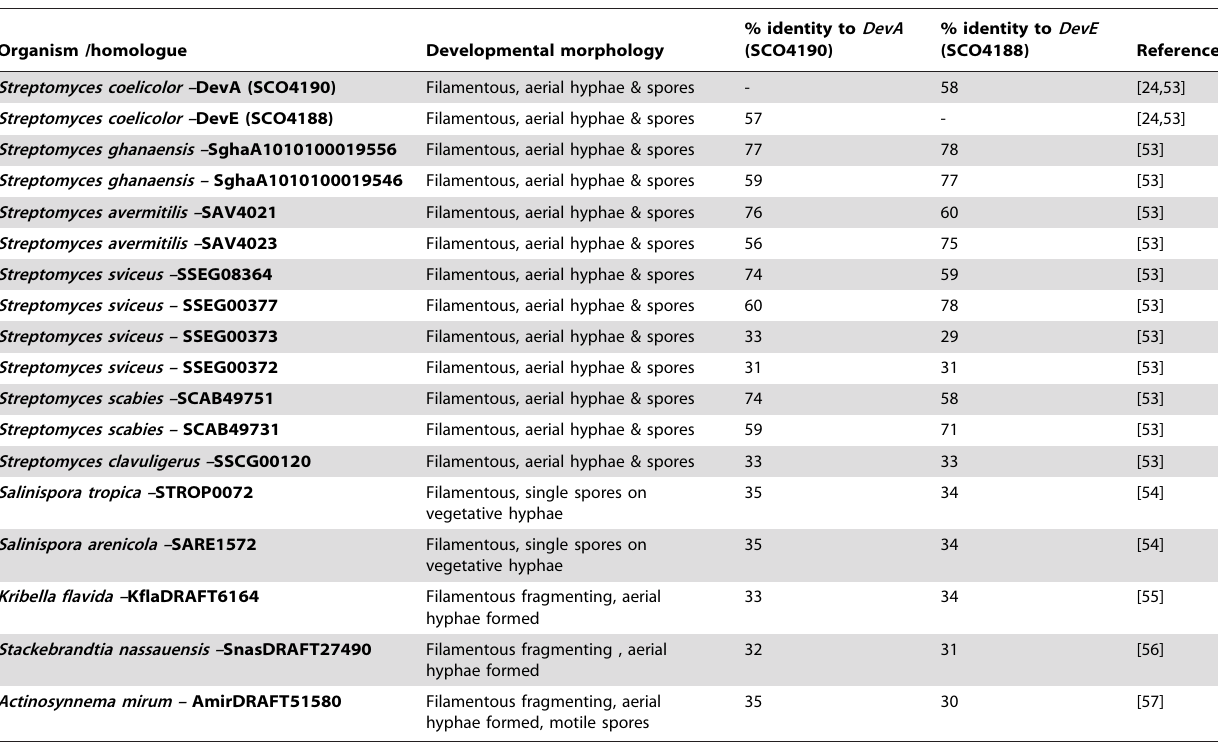
Table 2. Homology and Morphology of selected strains containing devA -like